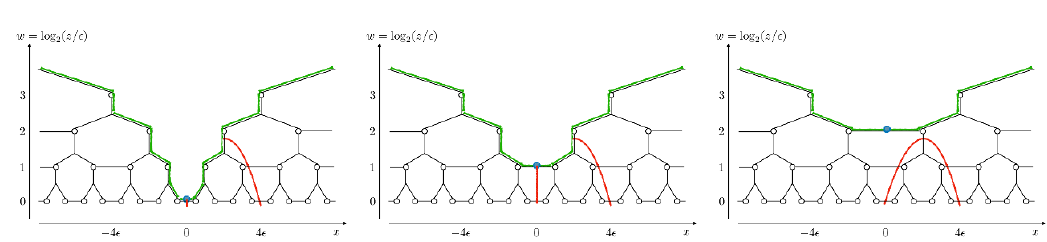
Figure 26 . Time evolution of the tensor network after joining quench. The left, middle and right picture correspond to t = (cid:15) , 2 (cid:15) and 4 (cid:15) , respectively. The red curve shows the minimum curve in the bulk. The blue dot and green curve are dual to the falling particle and boundary surface Q . Here, A = f x j x 2 (0 ; 4 (cid:15) ) g .